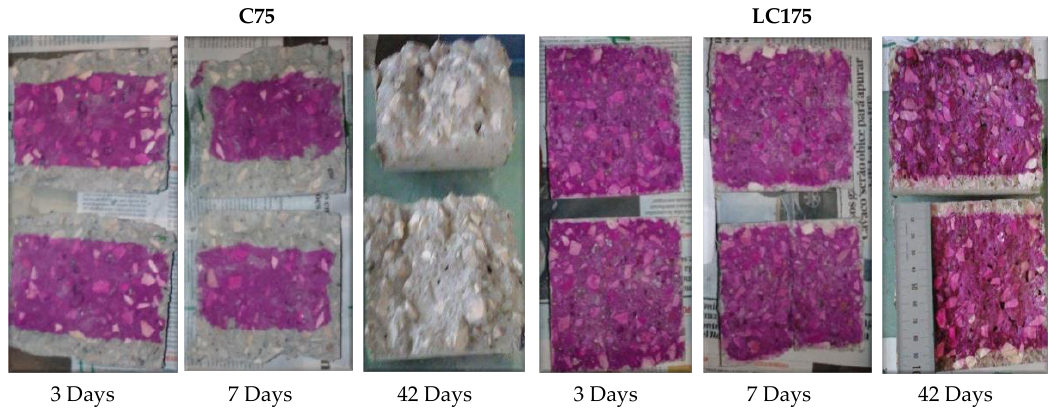
Figure 17. Concrete specimens C75 and LC175 with phenolphthalein after 3, 7 and 42 days of exposure to CO 2 .